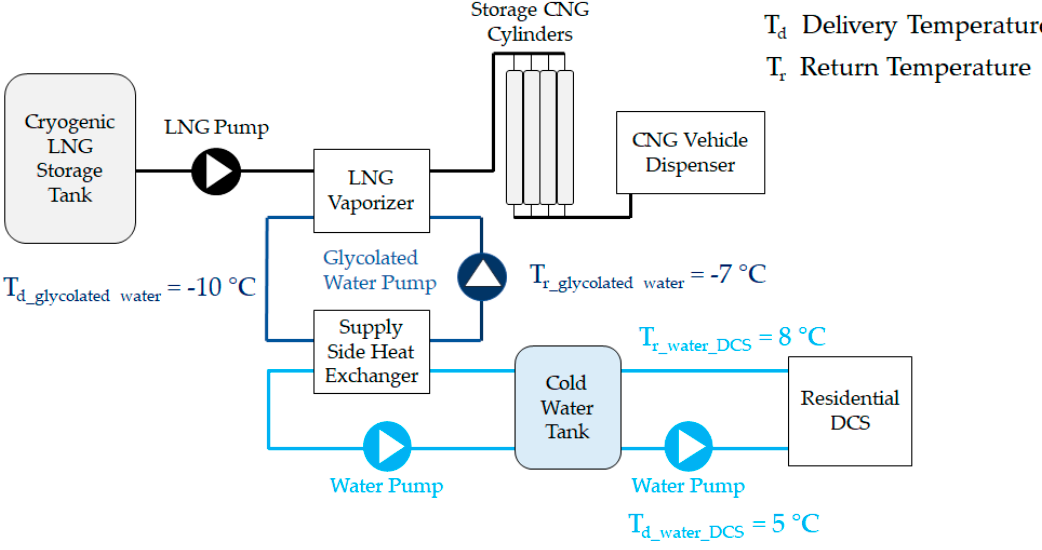
Figure 1. Plant scheme: cooling energy recovery from liquid to compressed natural gas (L–CNG) vaporizer to fulfil a residential district cooling systems (DCS) (focus on the cooling supply side).